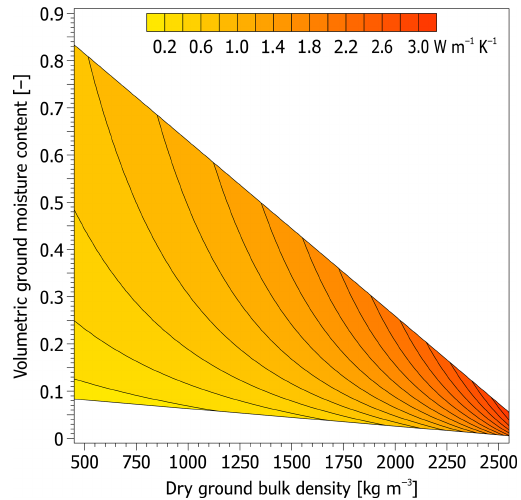
Figure A2. Thermal conductivity of the thawed ground as a func- tion of its dry bulk density and volumetric moisture content cal- culated using the Johansen (1977) thermal conductivity model for thawed fine substrates with a degree of saturation of > 10% to 100% and a quartz content of 40%. Note that the white areas are outside the saturation